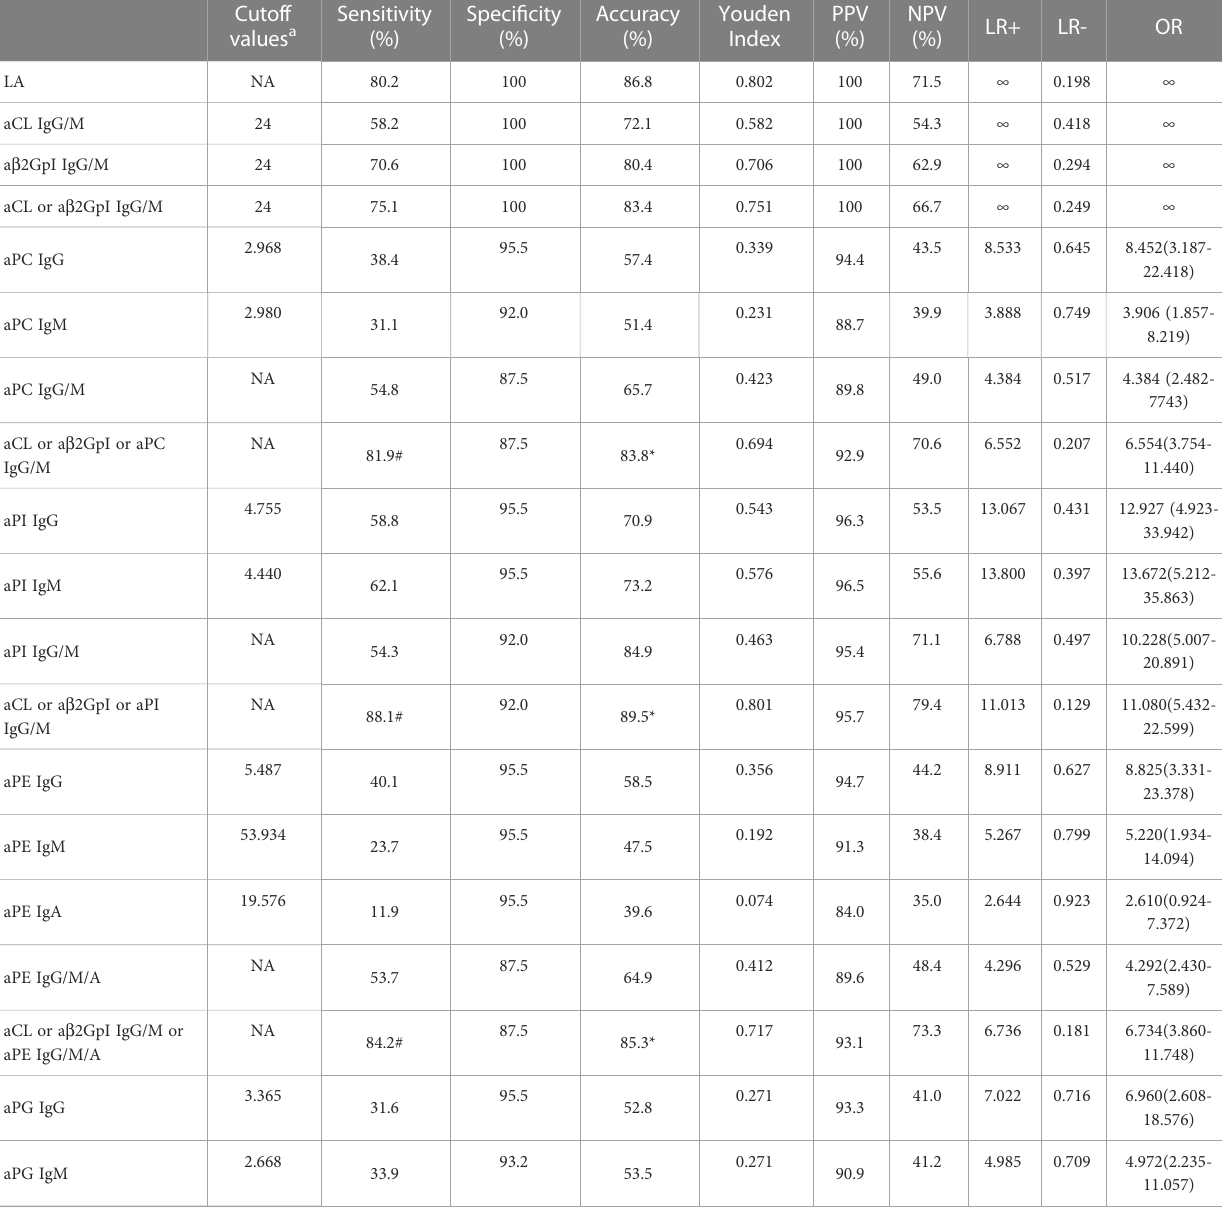
TABLE 2 Predictive value of aPLs for APS